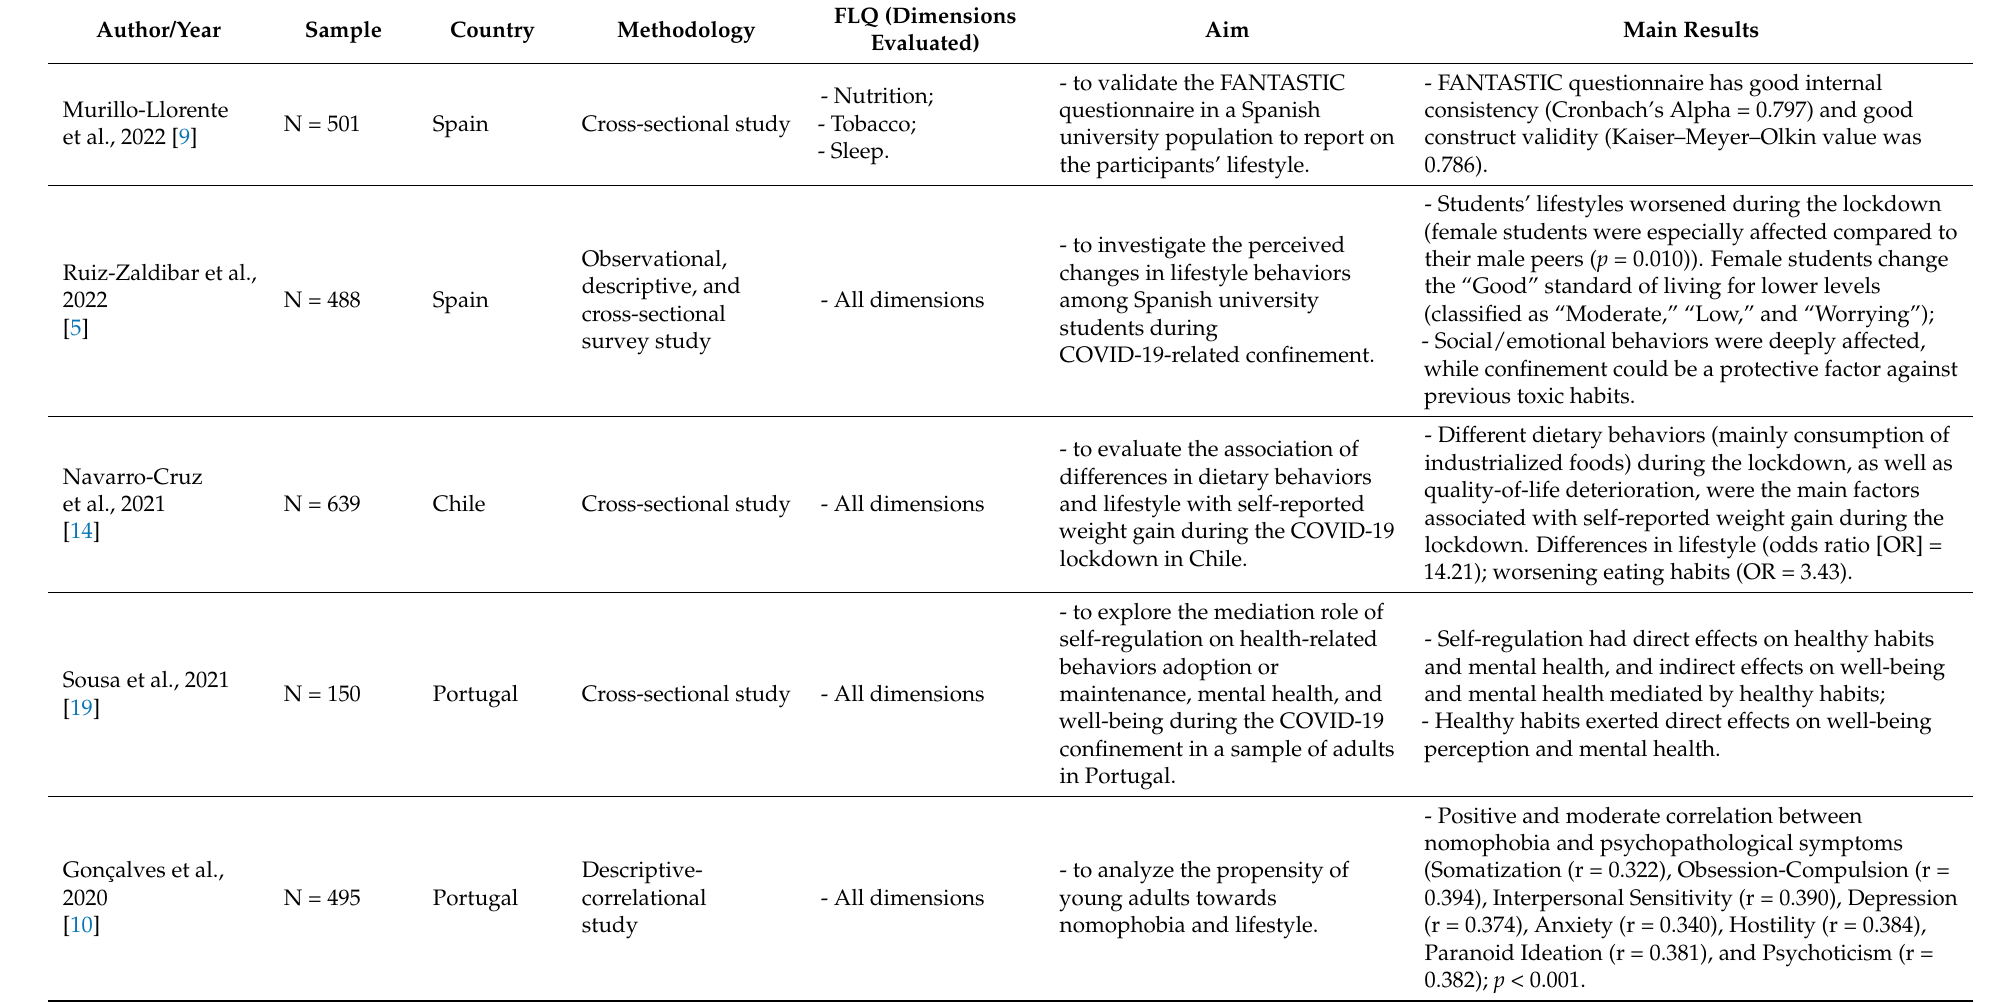
Table 2. Summary of the studies included in the